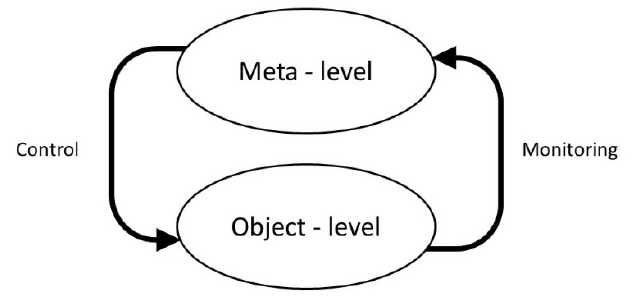
Figure 2. Nelson and Narens’ theoretical framework for metamemory (adapted from